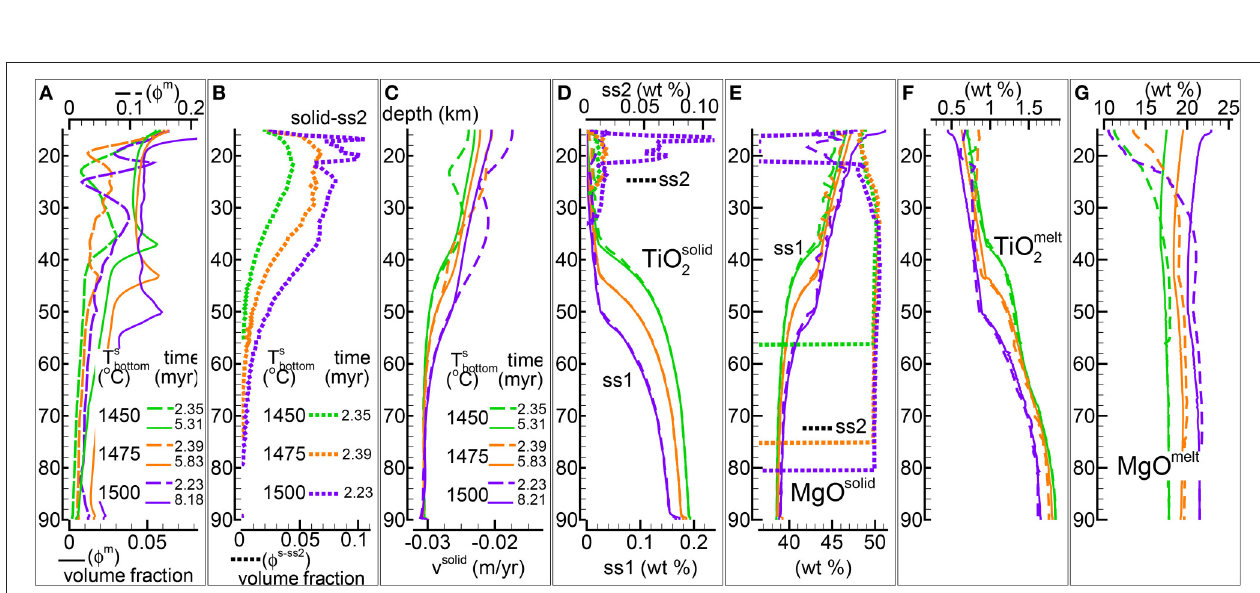
FIGURE 5 | DFM simulations assuming different temperatures at the bottom, 1,450 ◦ C (green lines), 1,475 ◦ C (orange lines), 1,500 ◦ C (purple lines). Solid viscosity model: µ s = µ s 0 with µ s 0 = 1 e 21 Pa s, permeability constant C =1e9 m − 2 , fixed velocity of the solid at the bottom -0.03 m/yr. (A) Melt volume fraction vs. depth at 2 different times (solid and dashed lines). Earliest time coincides approximately with the largest amount of melt reaching the top side. (B) Volume fraction of solid in sub-sys 2 at the earliest time. (C) Velocity of the solid matrix. (D–G) Variation of the solid and melt composition (wt %). (D) TiO 2 in solid, also the solid in sub-system 2 (ss2, dotted lines). (E) MgO in solid , also the solid in sub-system 2 (ss2, dotted lines). (F) TiO 2 in melt. (G) MgO in melt. The data files can be downloaded following the link provided in the Supplementary Material, zip file max-front2-data.zip , PHASE3B.YRC1.DAT , PHASE3B-P.YRC10.DAT , PHASE3B-P.YRC12.DAT .